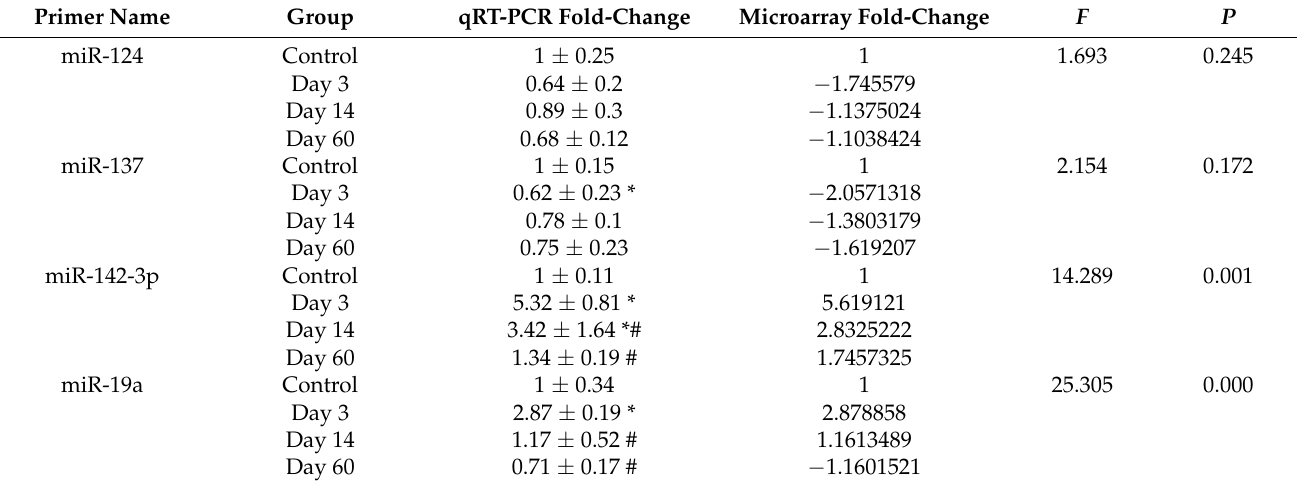
Table 1. Validation of microarray results in the CA area by qRT-PCR.